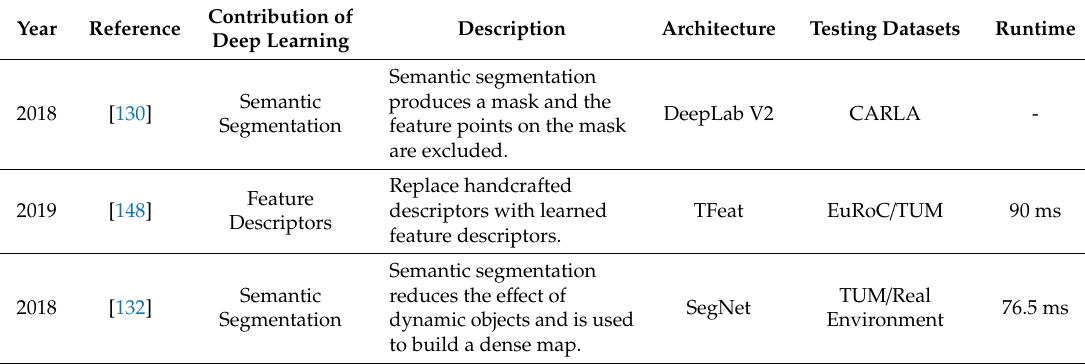
Table 7. Summary of recent deep-learning-based SLAM